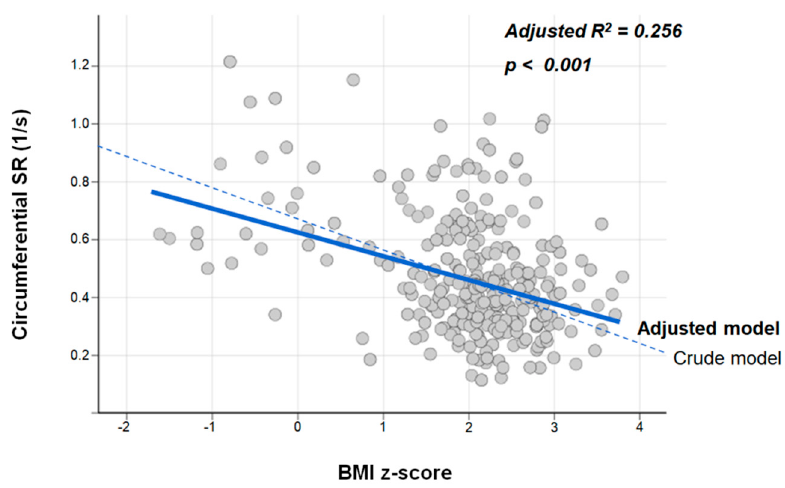
Figure 3. Multiple linear regression fit of the circumferential SR on the BMI z-score. SR, strain rate; BMI, body mass index.